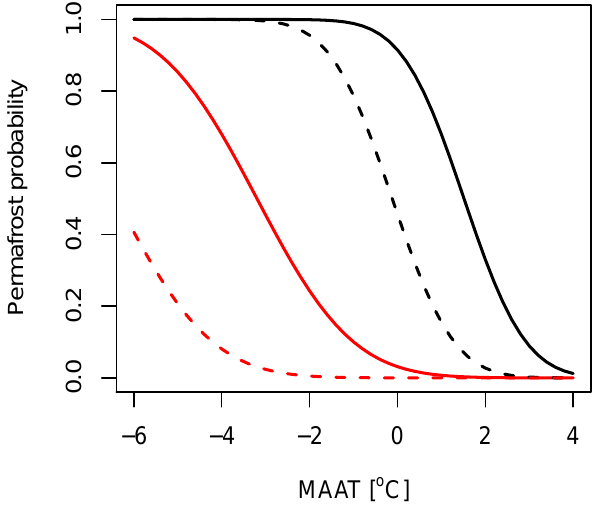
Fig. 4. Predicted probabilities of a rock glacier being intact (black) and of MARST ≤ 0 ◦ C in steep bedrock (red) for PISR = 100 Wm − 2 (solid line) and PISR = 300 Wm − 2 (dashed line). A precipitation value of 1271mm (cPRECIP = 0mm) was used for this